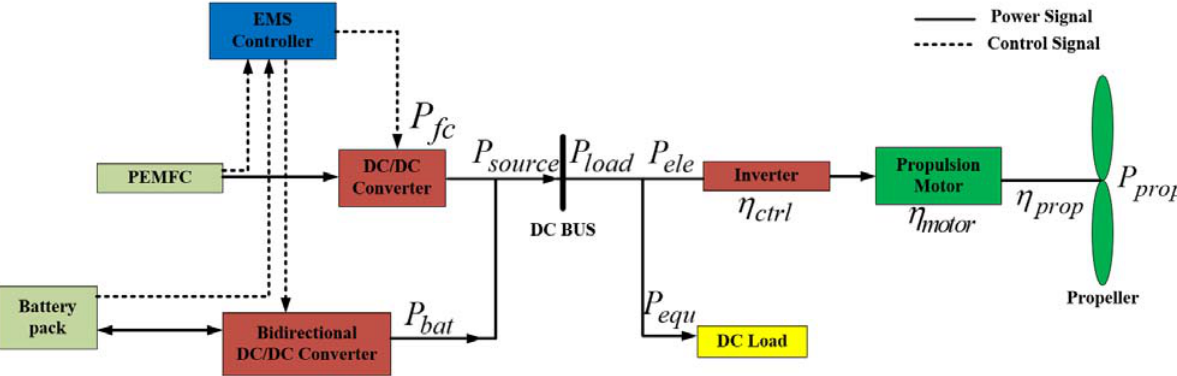
Figure 2. The power architecture of HEPS in UAV.